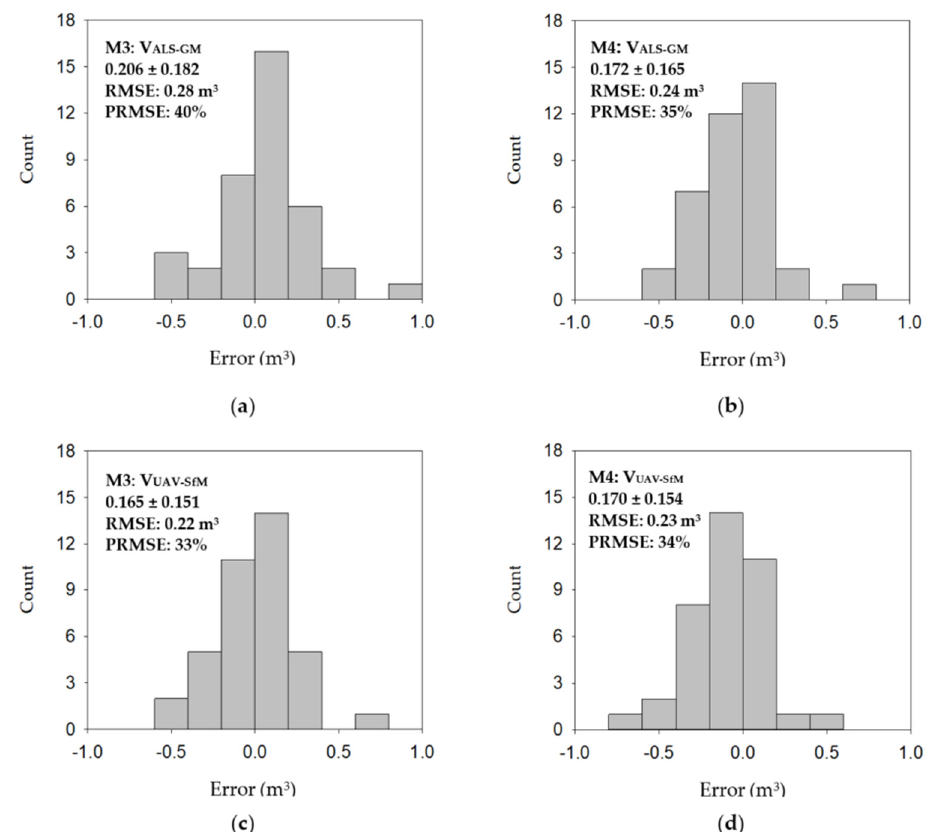
Figure 11. A comparison of the distribution of tree-volume estimation error in M3 and M4 models with the ALS-GM ( a , b ) and UAV-SfM ( c , d ) point cloud datasets. The histogram displays the error of integrated sample trees from both the Kameyama and Owase forest stands. The x-axis is the difference between the predicted and measured values and the y-axis is the count of the errors. The average and standard deviation of estimation error embedded in each subfigure are given at the base of absolute error.